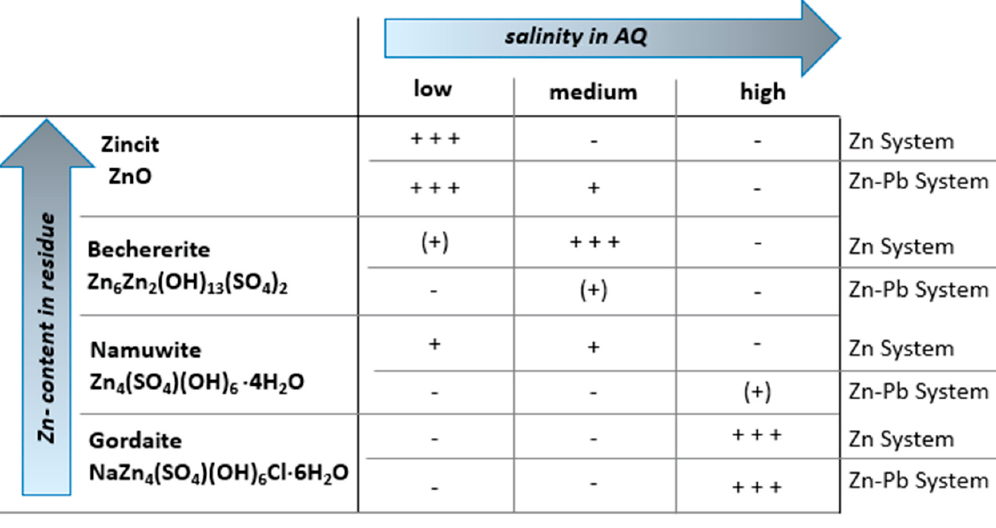
Figure 8. Crystalline phases in the Zn system (exp. set 1) and the Zn–Pb system (exp. set 2) as a function of the salinity in the AQ (the number of + equals the relative amount of the phase in the residue, (+) indicates traces of the phase, - means phase not present).